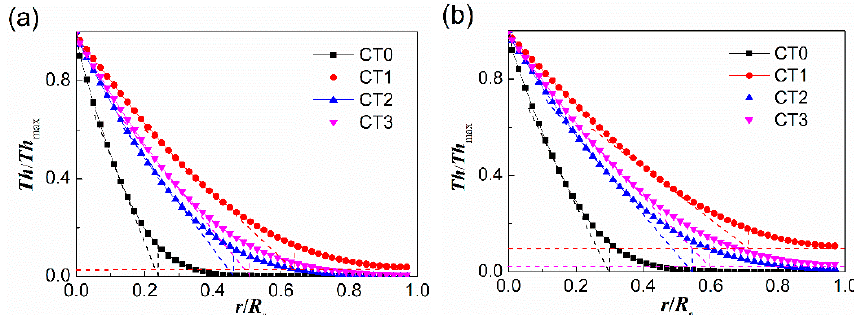
Figure 9. Changes in the ratio of Th / Th max at different radial coordinate of porous sensors based on samples CT0, CT1, CT2, and CT3. ( a ) Test time 10 s; ( b ) Test time 20 s.